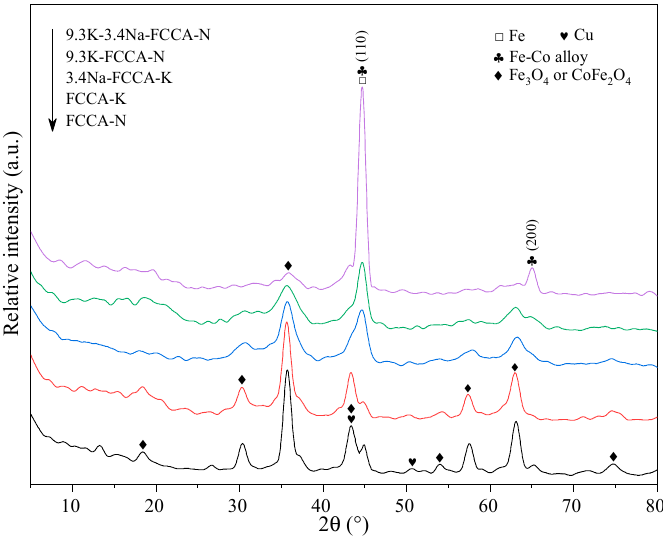
Figure 1. XRD pattern of reduced FeCoCuAl catalysts before and after K and/or Na modification. Catalyst reduction at 400 °C for 1 h in pure H 2 .